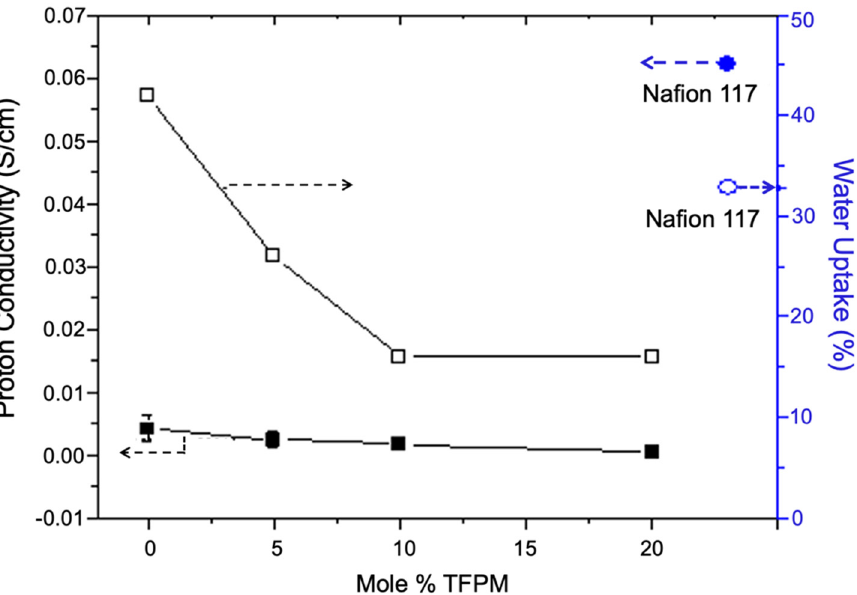
Figure 10. The effect of hydrophobic TFPM modification on the SX-10 proton conductivities at room temperature. The conductivities of ternary S0-10 membrane and the Nafion ® 117 membrane are included for comparison.